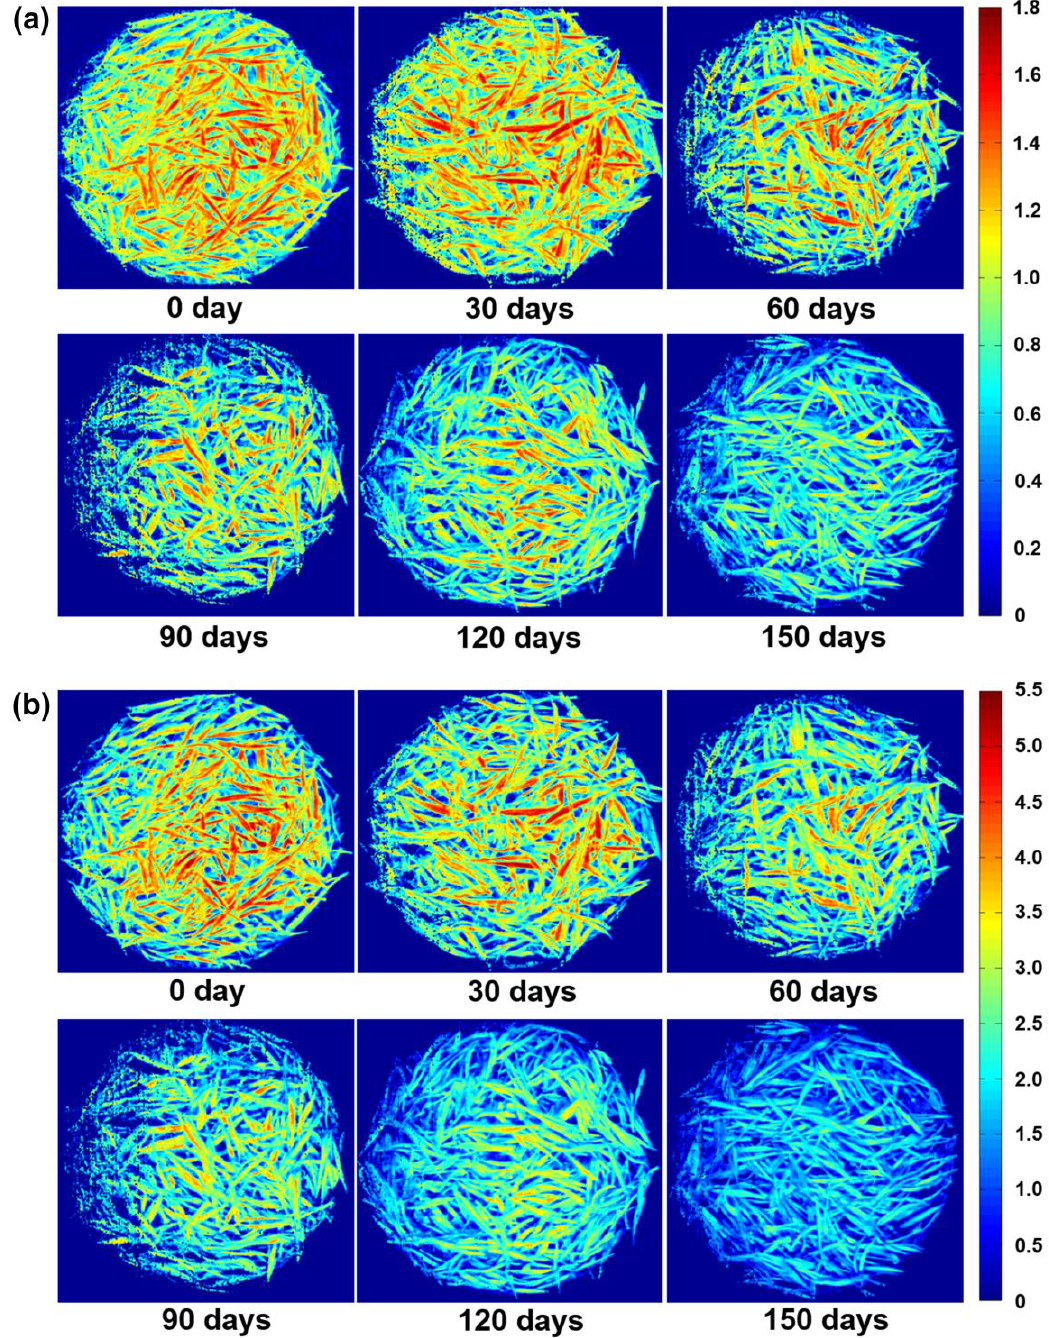
Figure 5. Distribution visualization maps of total saturated ( a ) and total unsaturated fatty acids ( b ) in tea samples with different storage duration.